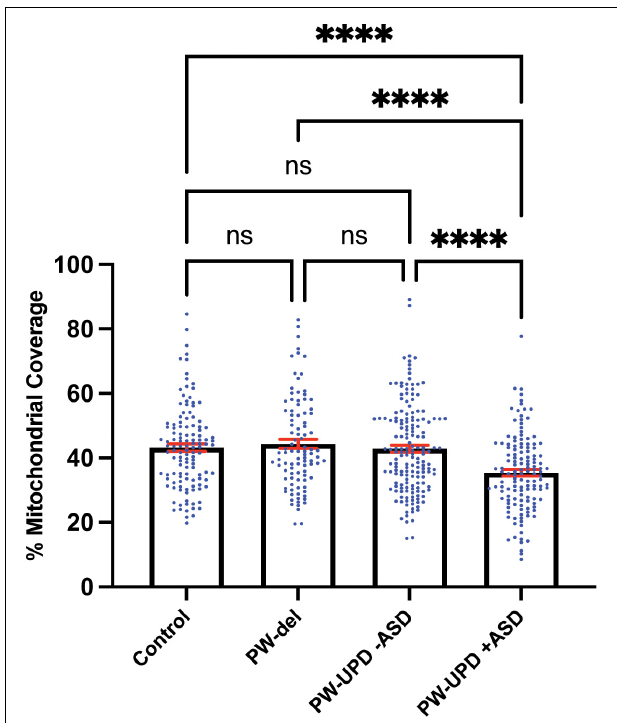
FIGURE 7 | PW-UPD + ASD neurons show decreased mitochondrial coverage within neuronal area. Using Imaris, the total neuronal area (anti-Beta Tubulin) that contains mitochondria (anti-TOMM20) was calculated. Percent of mitochondrial coverage was measured for ≥ 15 neurons from each cell line and at least 5 cell lines per group in a blinded fashion. Significance testing was performed by both ordinary one-way ANOVA and Turkey’s multiple comparisons test with a single pooled variance. ns = not significant, **** = p -value ≤